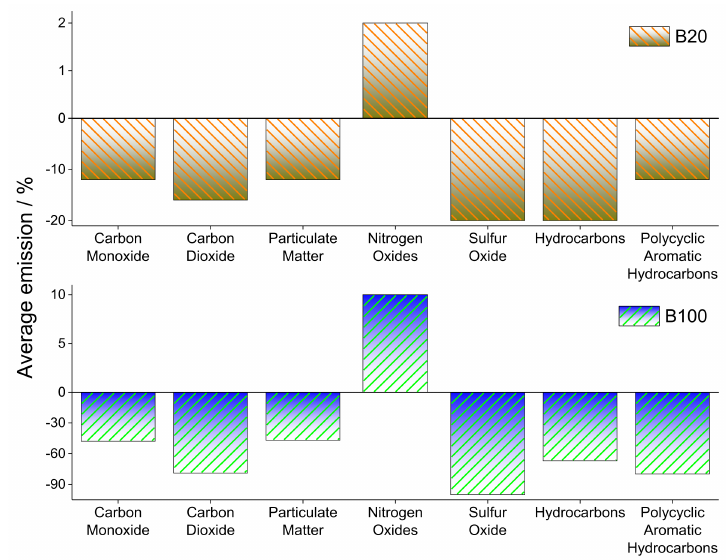
Figure 1. Pollutants average emission by the B-20 and B-100 (adapted from [7]).